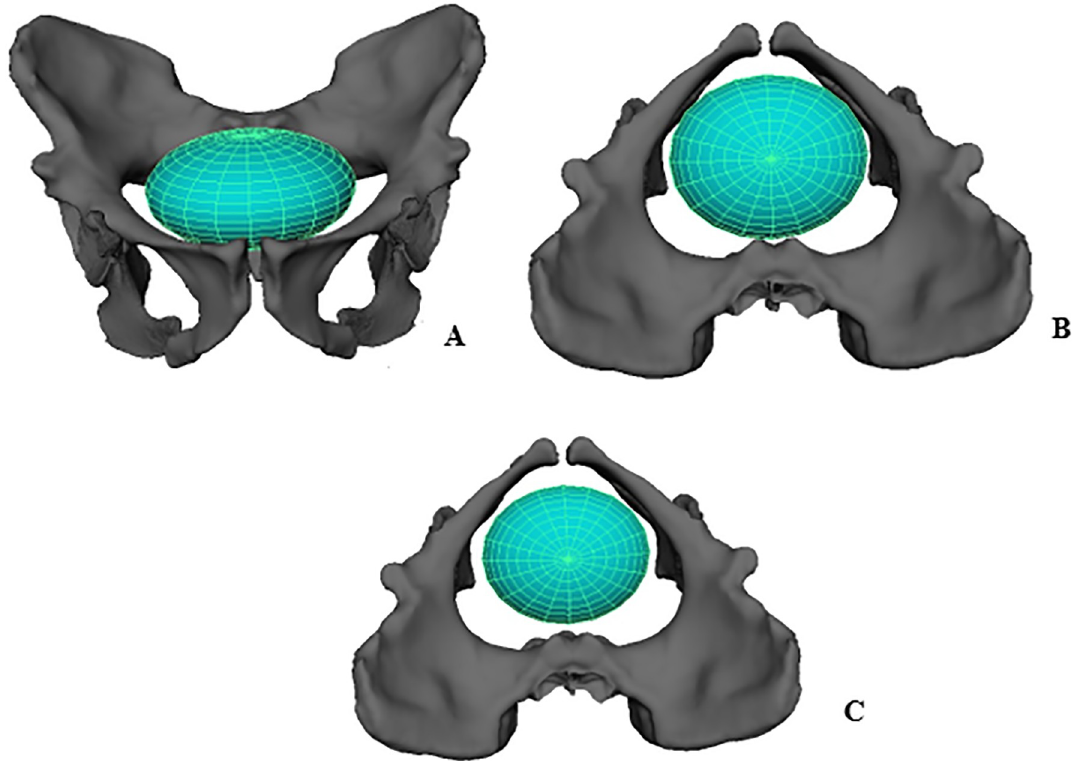
Fig 4. Ellipse representing a neonatal A . sediba head at the pelvic. A. inlet, frontal view B. inlet, superior view C. midplane, superior view. Reconstructed pelvis is shown with the MH1 ischium. Notice that the modeled A . sediba neonatal cranium can descend into the midplane without bony constraints, unlike the condition typically found in modern